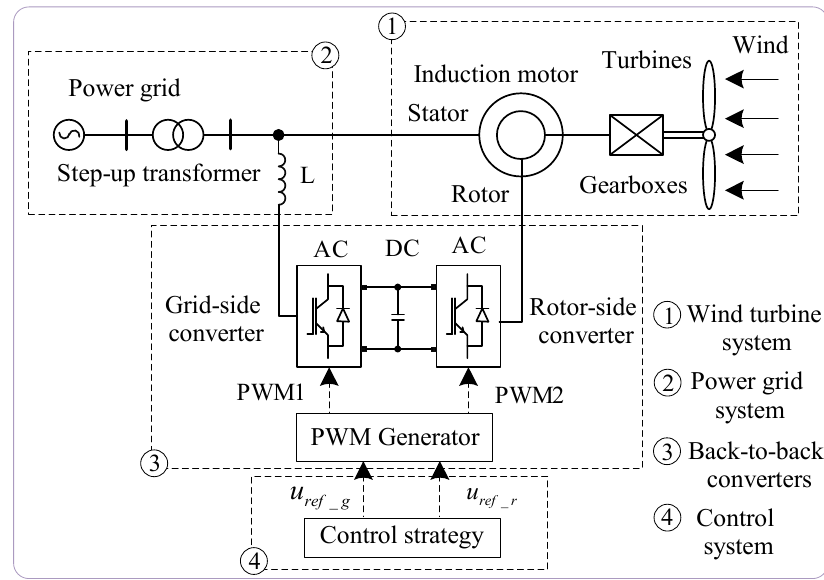
Figure 1. The fundamental structure of a doubly fed wind power system. In the figure, parameters u ref _ g and u ref _ r represent the modulating voltages from the control system on the grid side and rotor side, respectively, and PWM1 and PWM2 are the trigger pulses of the converter on the grid side and rotor side. To understand the basic structure of the system in more detail, the back-to-back converter is listed separately. As shown in Figure 2, it consists of three sets of insulated-gate bipolar transistors (IGBTs) that are completely symmetrical about the DC bus capacitance. In this case, the modulating waves on both sides are compared with the high-frequency carrier waveform to generate three pulse signals, g ( and g (cid:48) , respectively. Considering the trigger pulses of the 1,3,5 ) ( 1,3,5 ) upper and lower bridge arms of each group of converters as ideal complementary PWM waves, the control signals of the whole back-to-back converters can be obtained by inverting the three-way signals by bit. In the figure, C indicates the DC bus capacitor, g 1 indicates the trigger pulse of the upper bridge arm of the first converter, and g 6 indicates the trigger pulse of the lower bridge arm of the second